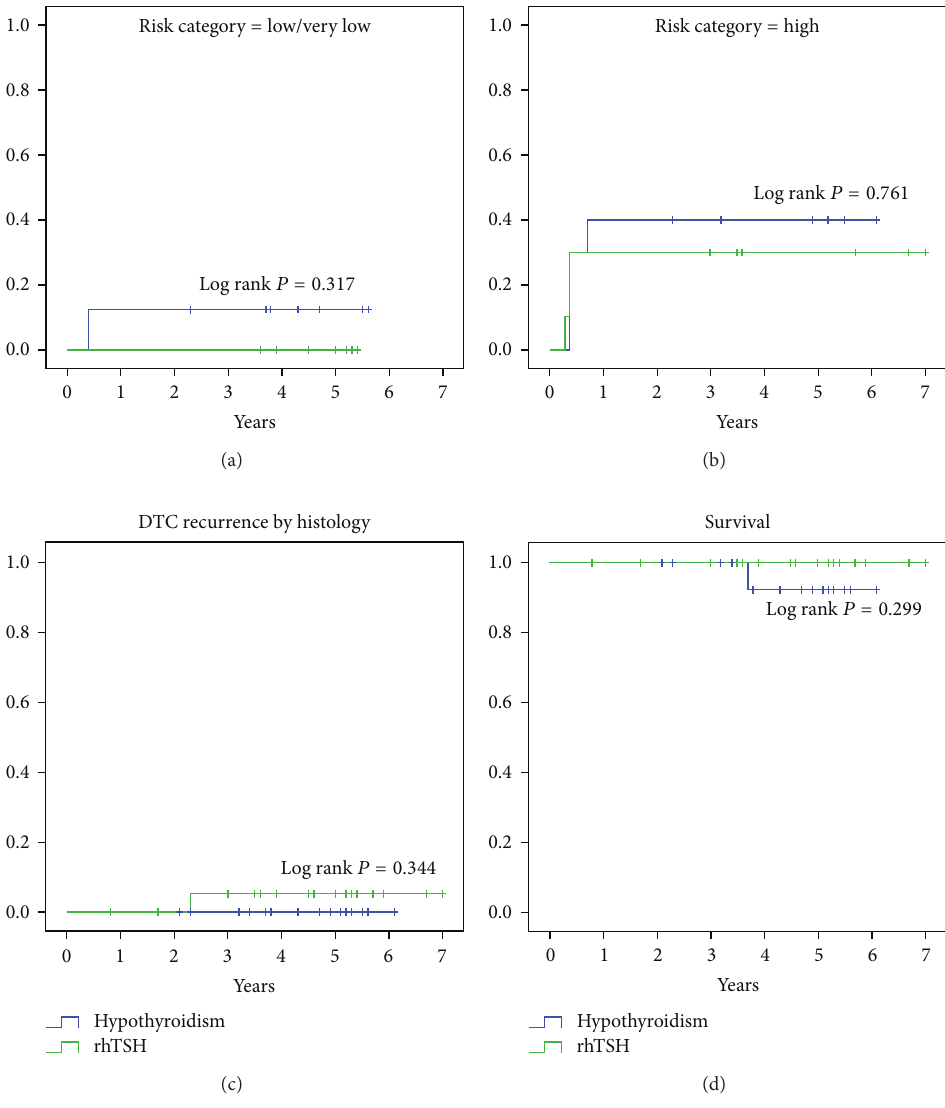
Figure 1: DTC-recurrence and patient survival. Statistically there was no significant difference in numbers of suspected DTC recurrences in (a) low/very low and (b) high-risk DTC categories as well ( Log Rank 𝑃 = 0.317 ; Log Rank 𝑃 = 0.761 , resp. ). (c) Histological evidence (lymph node and bone metastasis) for DTC recurrence was found only in one case. (d) There was no difference in patient survival ( Log Rank 𝑃 = 0.299 ). One patient of the hypothyroidism group died due to natural cause. Prior to death this patient had neither a suspected nor histological proven DTC